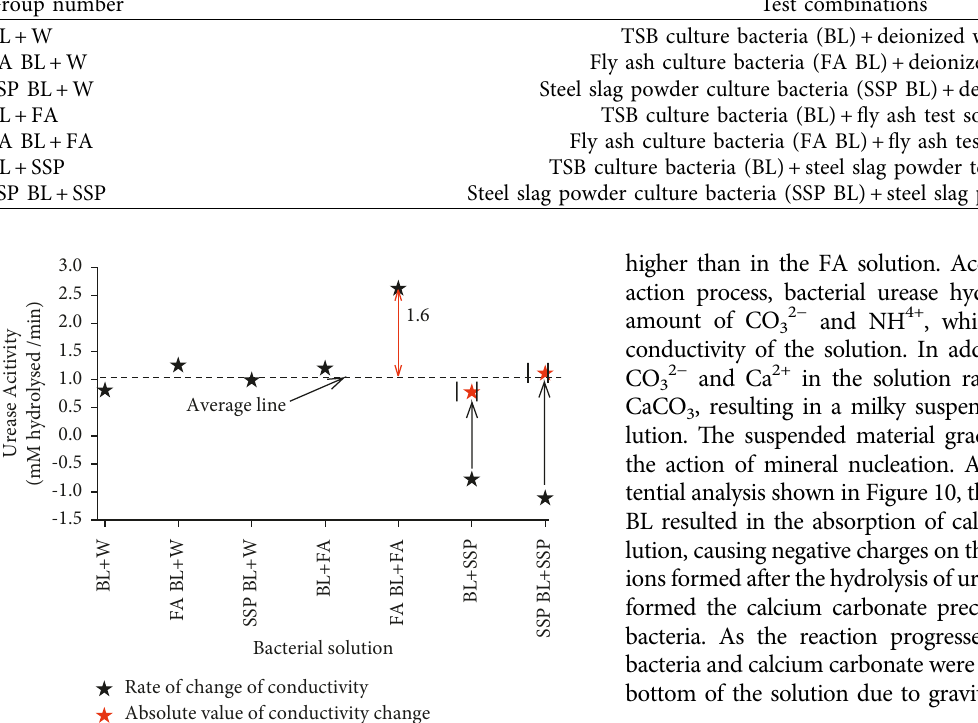
Figure 8: Growth characteristics of Sporosarcina pasteurii in aqueous solutions containing fly ash and steel slag Table 6: Urease activity test solution protocol. Group number